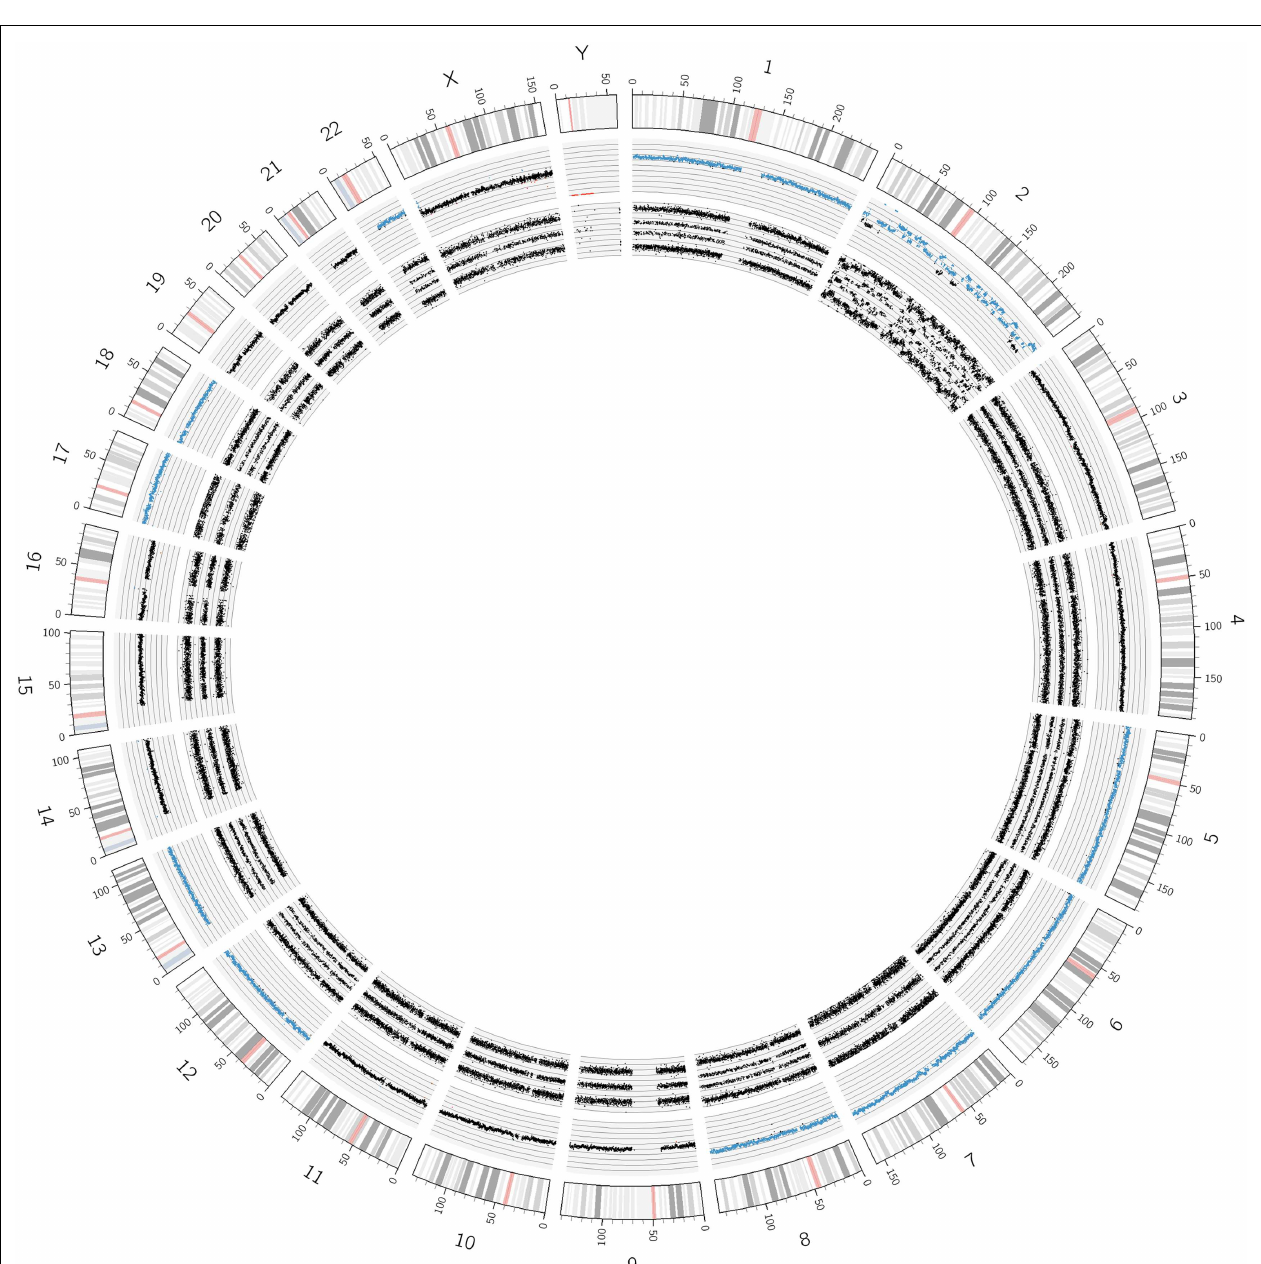
FIGURE 7 |An example of the recently described “chromothripsis .” As visualized by the Circos plot, only chromosome 2 but no other chromosome showed structural aberrations. However, the concerned chromosome underwent extreme shattering and reshuffling, as detailed in Figure 8